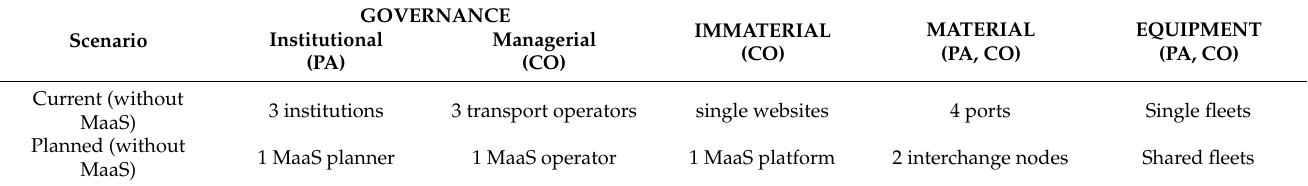
Table 2. The strait of Messina: scenario comparison for maritime